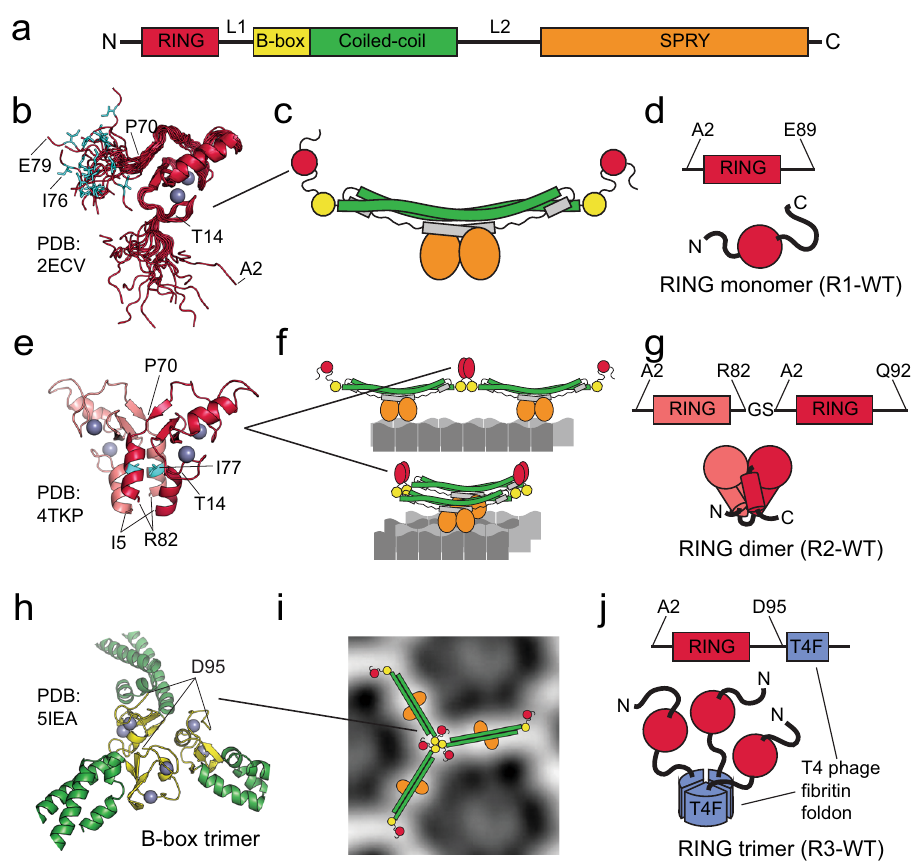
Fig. 1 | Recombinant RING constructs mimic distinct relative RING arrange- ments in TRIM5 α . a Conserved tripartite motif (TRIM) domain arrangement in TRIM5 α . b NMR structure of the human TRIM5 α RING domain monomer